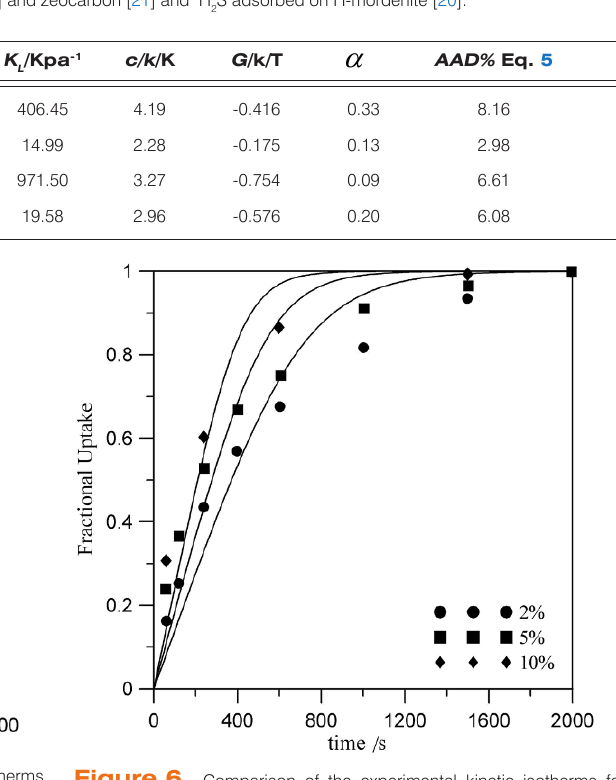
H adsorbed on 3 6